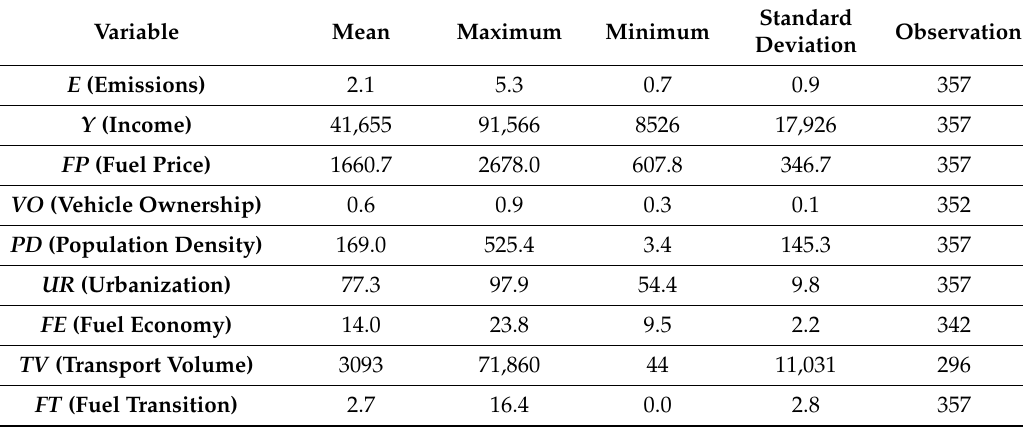
Table 2. Descriptive statistics.